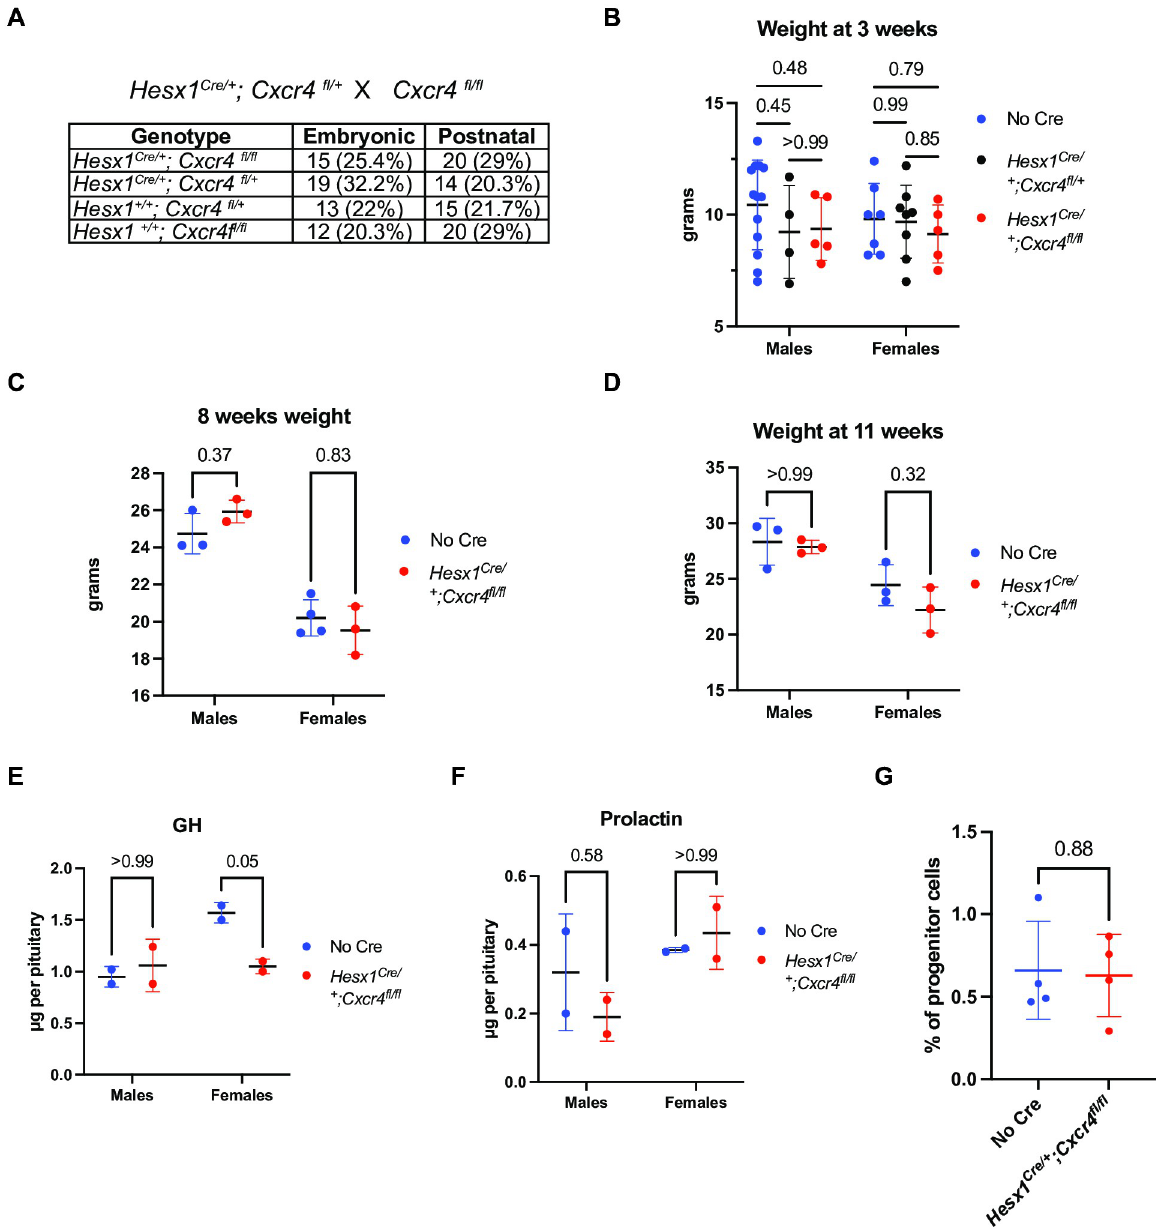
Fig 6. Phenotypic characterisation of postnatal Hesx1 Cre/+ ; Cxcr4 fl/fl pituitaries and mice. (A) Table showing normal observed Mendelian ratios for embryos and mice at weaning stage obtained from Hesx1 Cre/+ ; Cxcr4 fl/+ and Cxcr4 fl/fl crosses (N = 69, Chi-square test, p = 0.62). (B-D) Plots showing the weight of Hesx1 Cre/+ ; Cxcr4 fl/fl mice and controls separated by sex at 3, 8 and 11 weeks of age, respectively. Weight is not affected by the genotype at any analysed stage (two-way ANOVA with Bonferroni´s multiple comparisons test, N = 42 and P = 0.39 for 3 weeks; N = 13 and P = 0.6554 for 8 weeks; N = 12 and P = 0.2208 for 11 weeks). (E-F) Plots of total GH and PRL hormone content as measured by radioimmunoassay in male and female pituitaries at postnatal day 21 (n = 2, two-way ANOVA with Bonferroni´s multiple comparisons test, P = 0.1245 for GH and P = 0.6224 for PRL). (G) Plot of the percentage of progenitor cells present in wild type and mutant pituitaries at postnatal day 21 as evaluated through a clonogenic potential assay (n = 4, unpaired Student’s t-test, P = 0.88). Horizontal black lines in plots represent mean values and error bars show standard deviations. Significance values are shown for each pair-wise